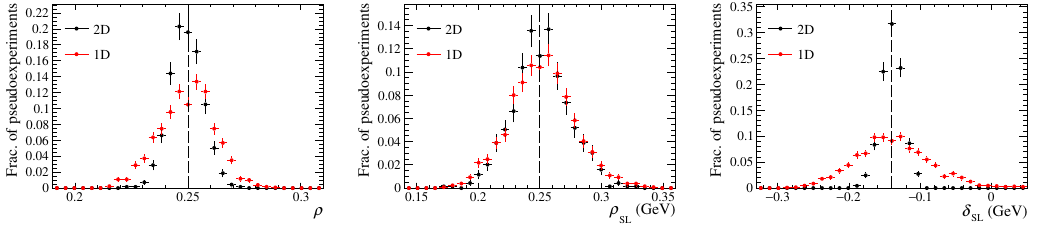
Figure 3 . Distribution of the IW parameters as (cid:12)tted from an ensemble of pseudo-experiments. The sensitivity is shown for (cid:12)ts to both the one-dimensional q 2 and two-dimensional q 2 (cid:2) cos (cid:18) l distributions. The dashed lines indicate the numerical values of the parameters used to generate the pseudoexperiments.